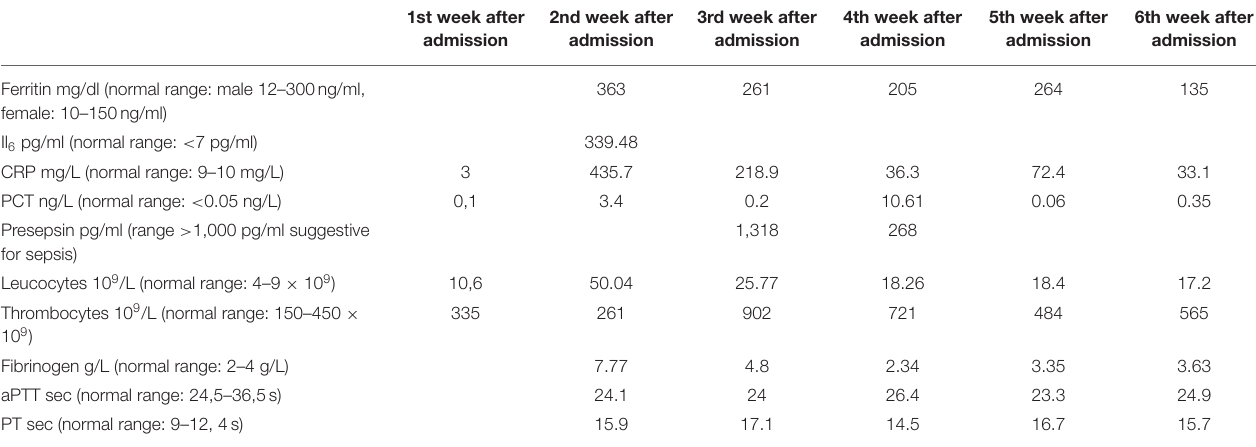
TABLE 1 | Relevant laboratory findings during hospital stay.